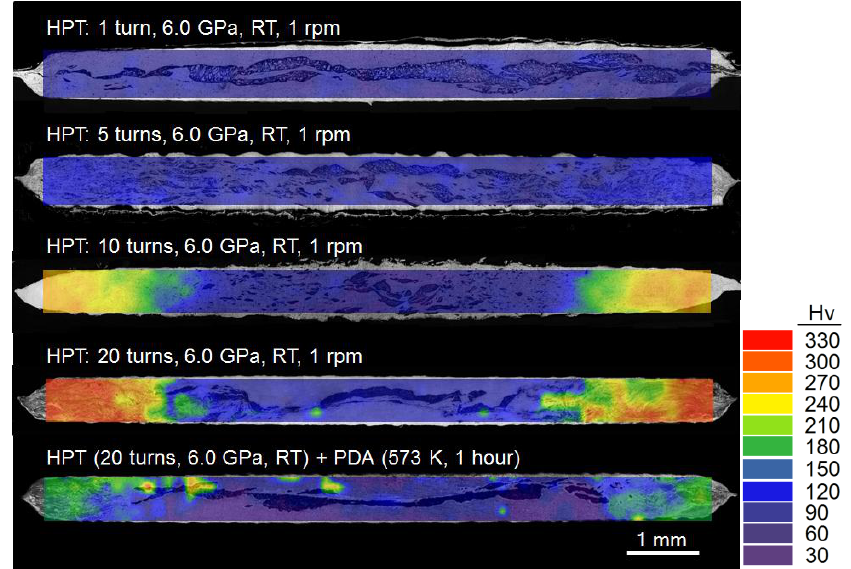
Figure 4. Color-coded hardness contour maps taken at the vertical cross-sections along the disk diameters after HPT for 1, 5, 10 and 20 turns [34] and after HPT for 20 turns followed by